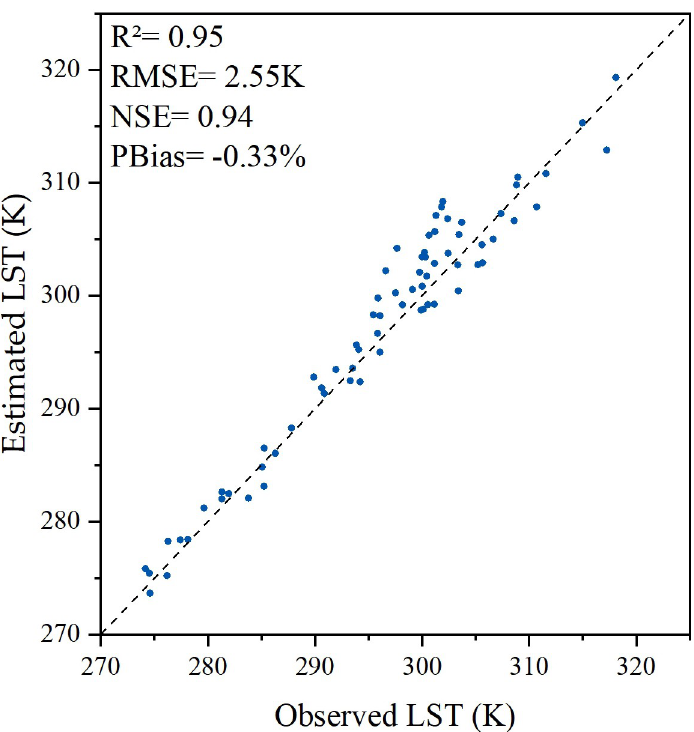
Fig 3. Validation of LST from STARFM simulation and LST from AWS